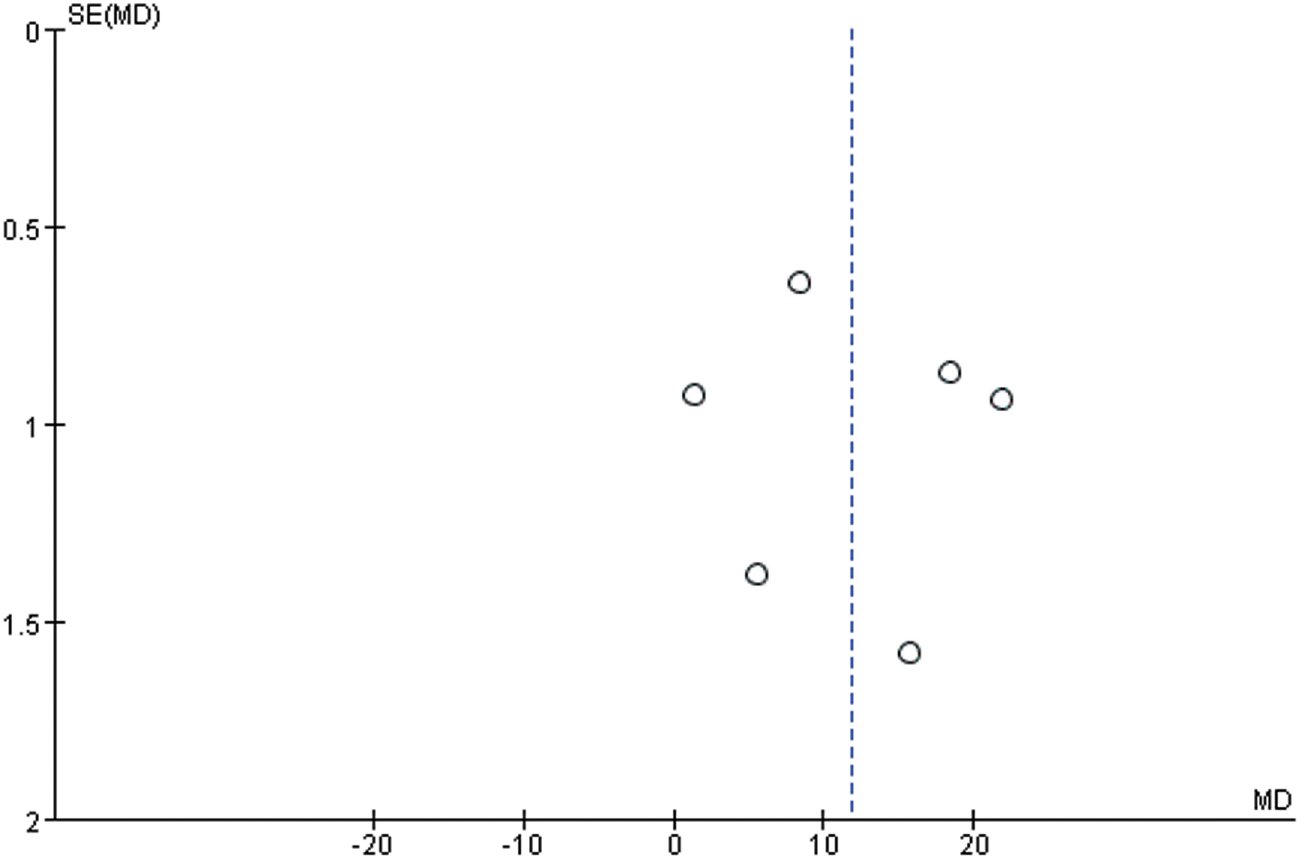
Fig 3. Funnel plot for traditional Chinese exercise on balance in short term. Short term: not longer than 3 months.